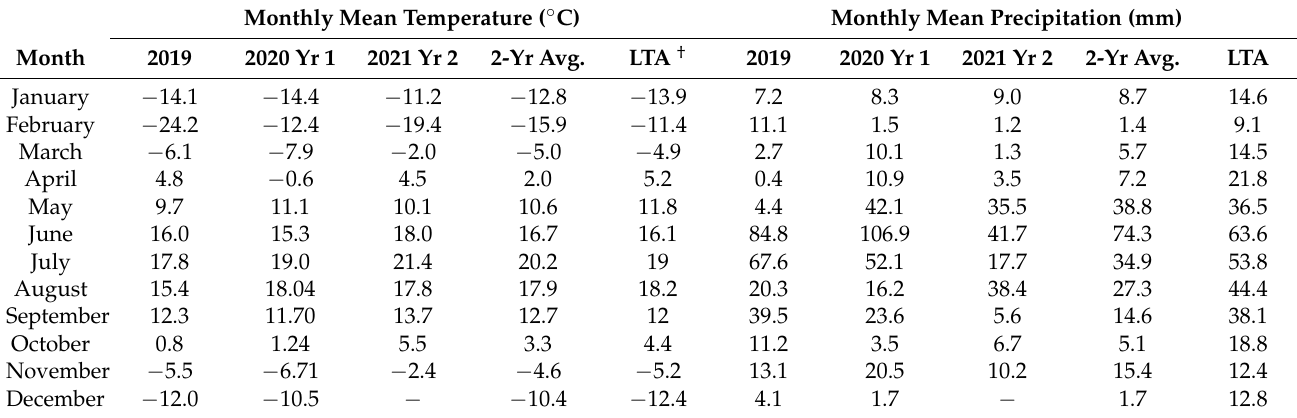
Table 1. Monthly mean air temperature and precipitation at LFCE, Saskatchewan, Canada in the dark brown soil zone over 3 yrs (2019–2021).